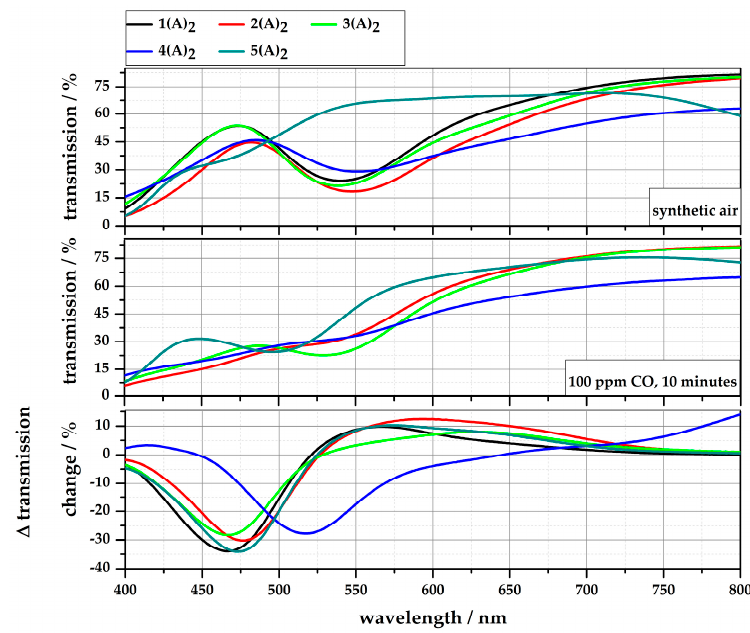
Figure 6. Difference of the transmission change ( Δ T/%) of the investigated Rh compounds before and after exposure to 100 ppm for 10 min.